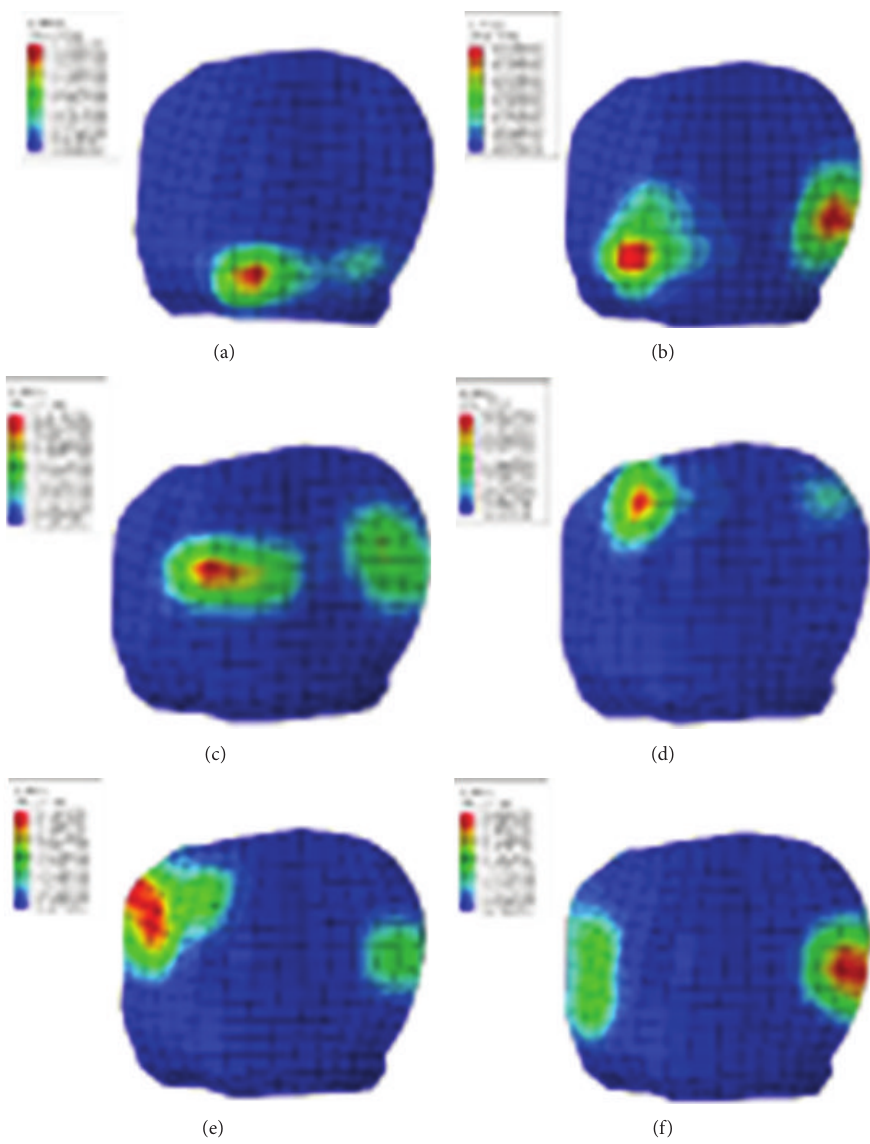
Figure 17: Contact stress of 0-30-60-90-130 degree flexion of tibiofemoral joint in FEA. (a) Stress distribution of 0 ∘ flexion. (b) Stress distribution of 30 ∘ flexion. (c) Stress distribution of 60 ∘ flexion. (d) Stress distribution of 90 ∘ flexion. (e) Stress distribution of 120 ∘ flexion. (f) Stress distribution of 130 ∘